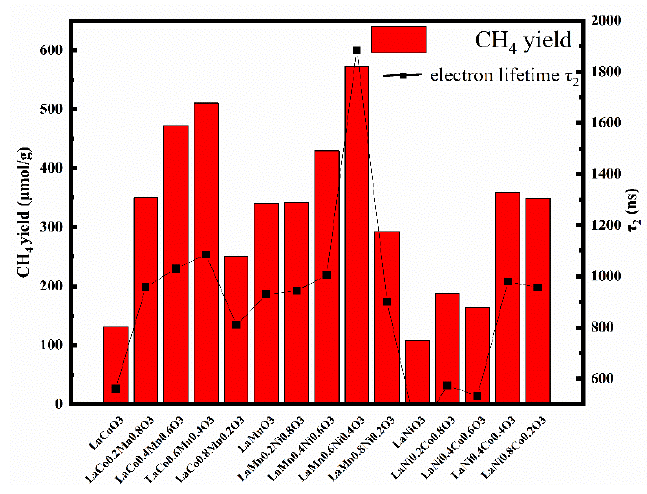
Figure 7. CH 4 yield corresponding to long electron lifetime τ 2 .